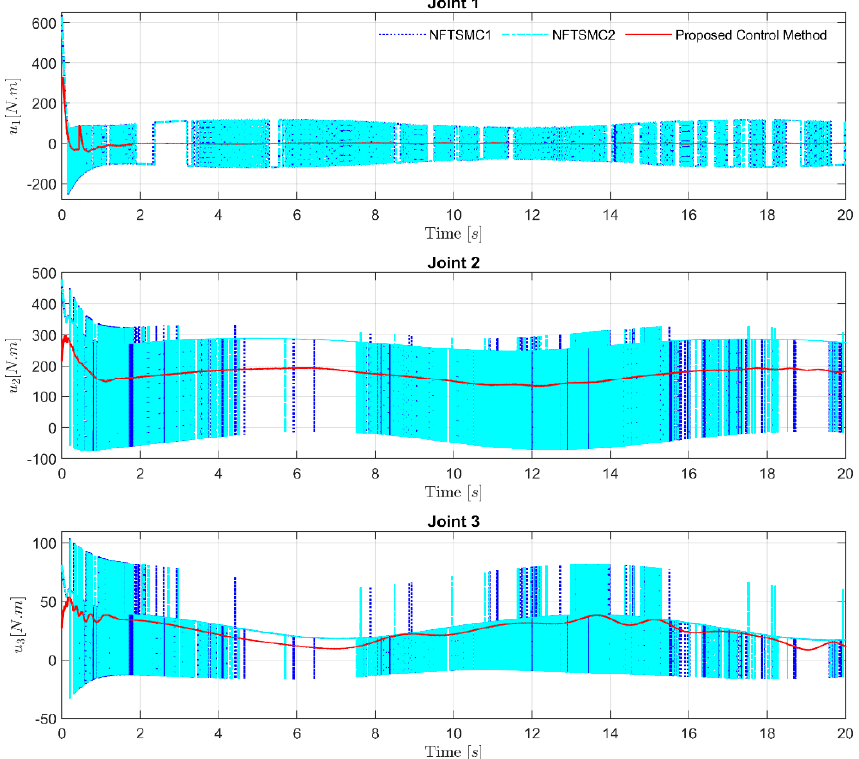
Figure 8. Control torque of the three different control strategies and comparison of chattering phenomena at each Joint.